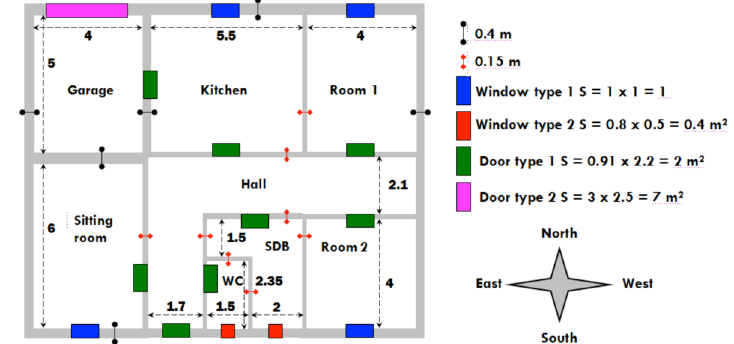
Fig. 2. Descriptive plane: southern orientation, dimensions are given by m .